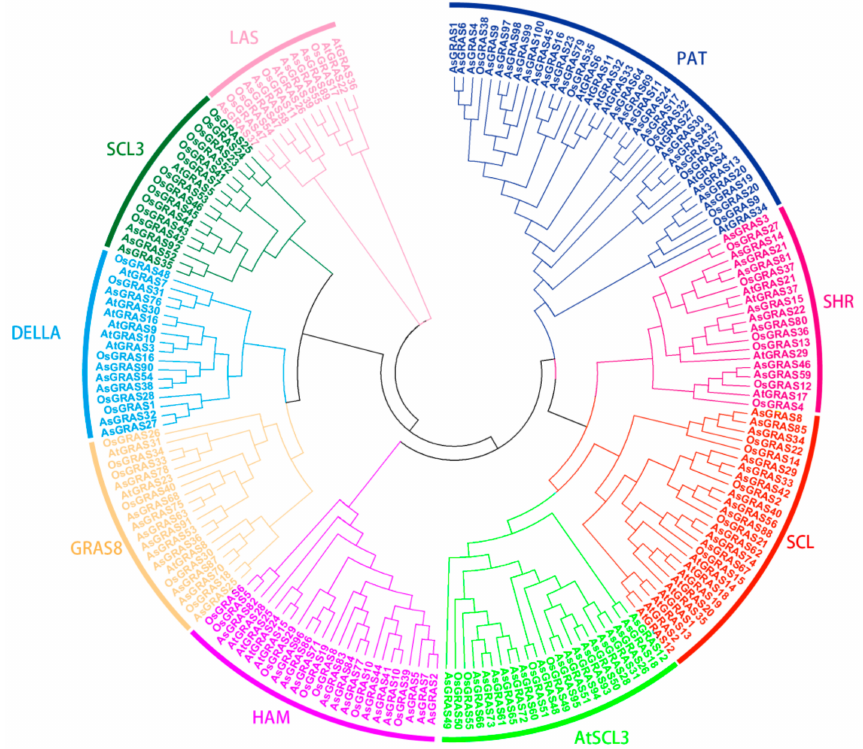
Figure 1. Phylogenetic tree of Avena sativa GRAS family